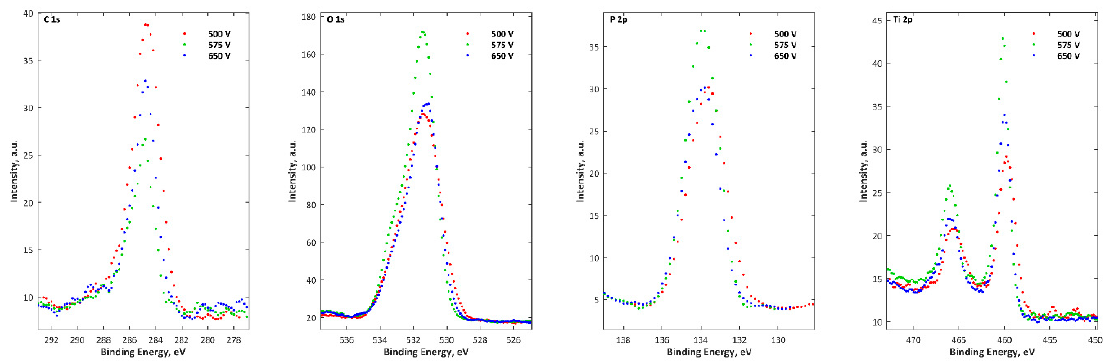
Figure 12. XPS signals of magnesium (Mg 2s, Mg KLL), zinc (Zn 2p 3/2 , Zn LMM) carbon (C 1s), oxygen (O 1s), phosphorus (P 2p) and titanium (Ti 2p) for samples after PEO processing obtained in electrolyte composed of 250 g/L Mg(NO 3 ) 2 ·6H 2 O and 250 g/L Zn(NO 3 ) 2 ·6H 2 O in H 3 PO 4 at three voltages, 500 V, 575 V, and 650 V.